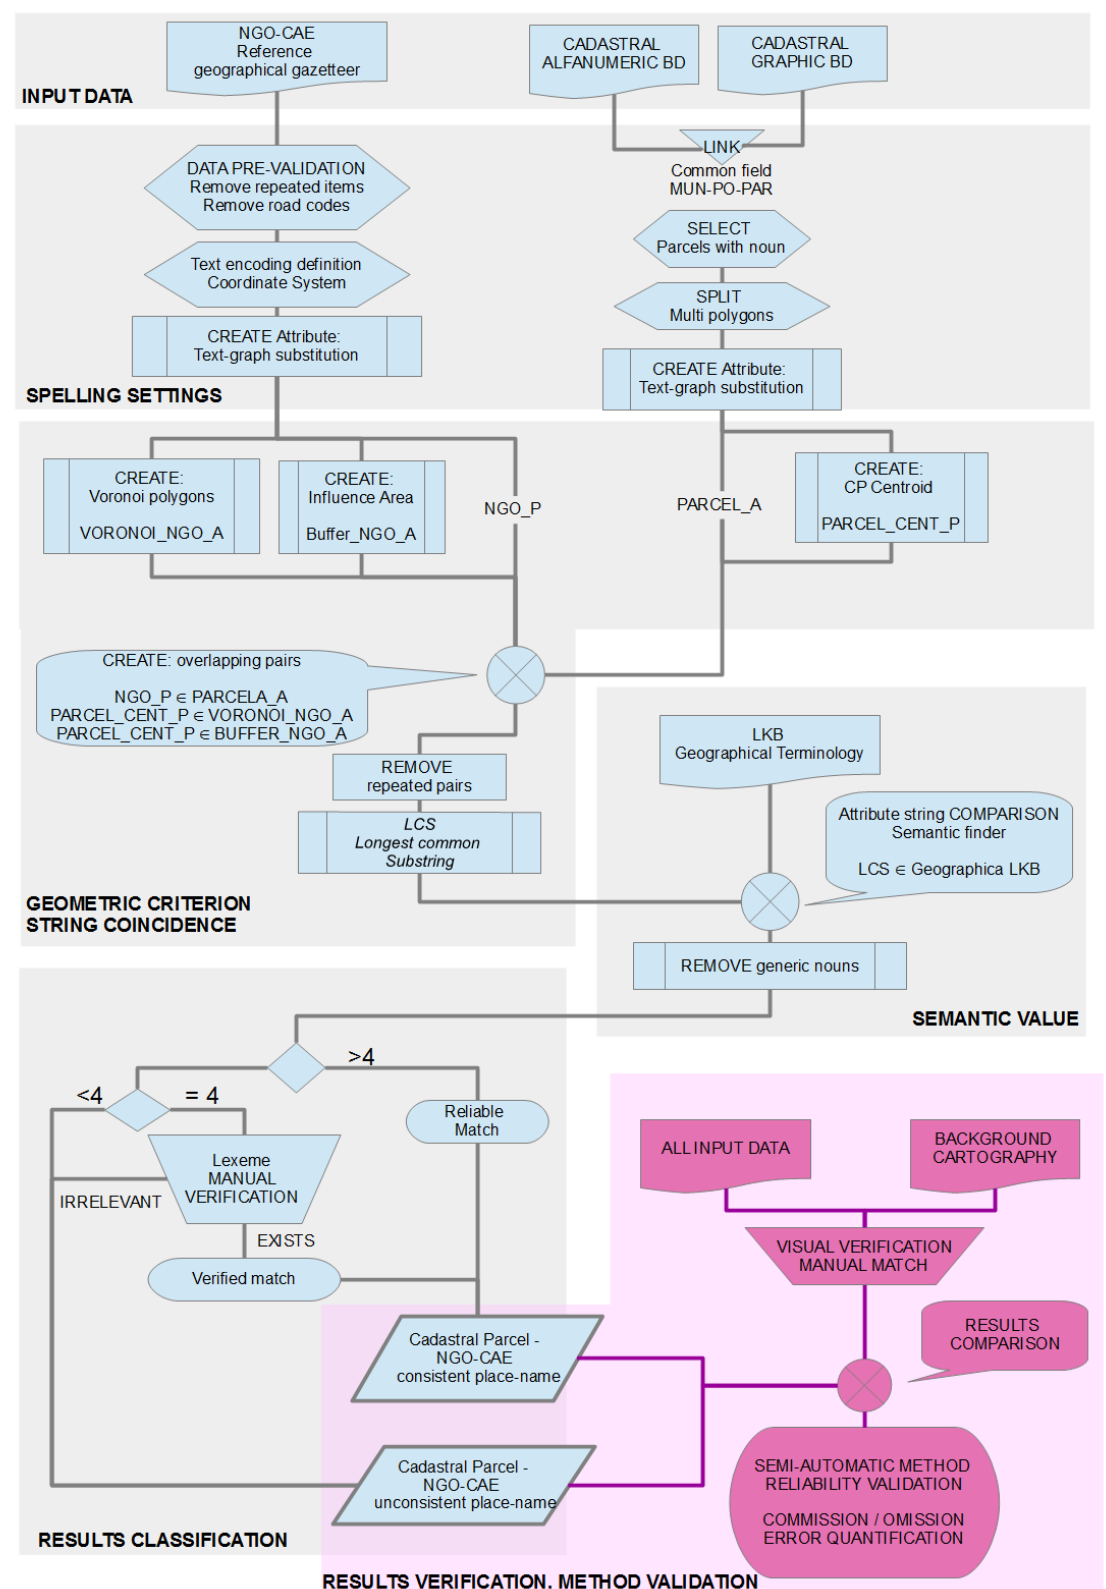
Figure 2. Flowchart with the process undertaken.